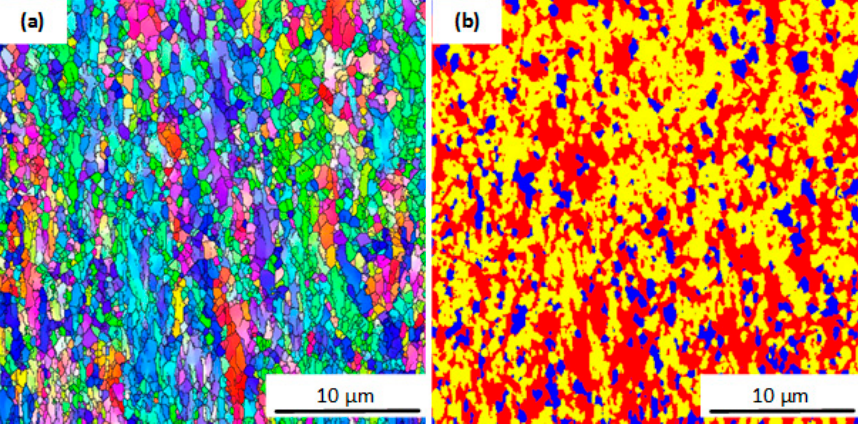
Figure 4. Microstructure of ultrafine grained (UFG) chips prepared by LSEM: ( a ) the inverse pole figure (IPF); ( b ) the recrystallization fraction.